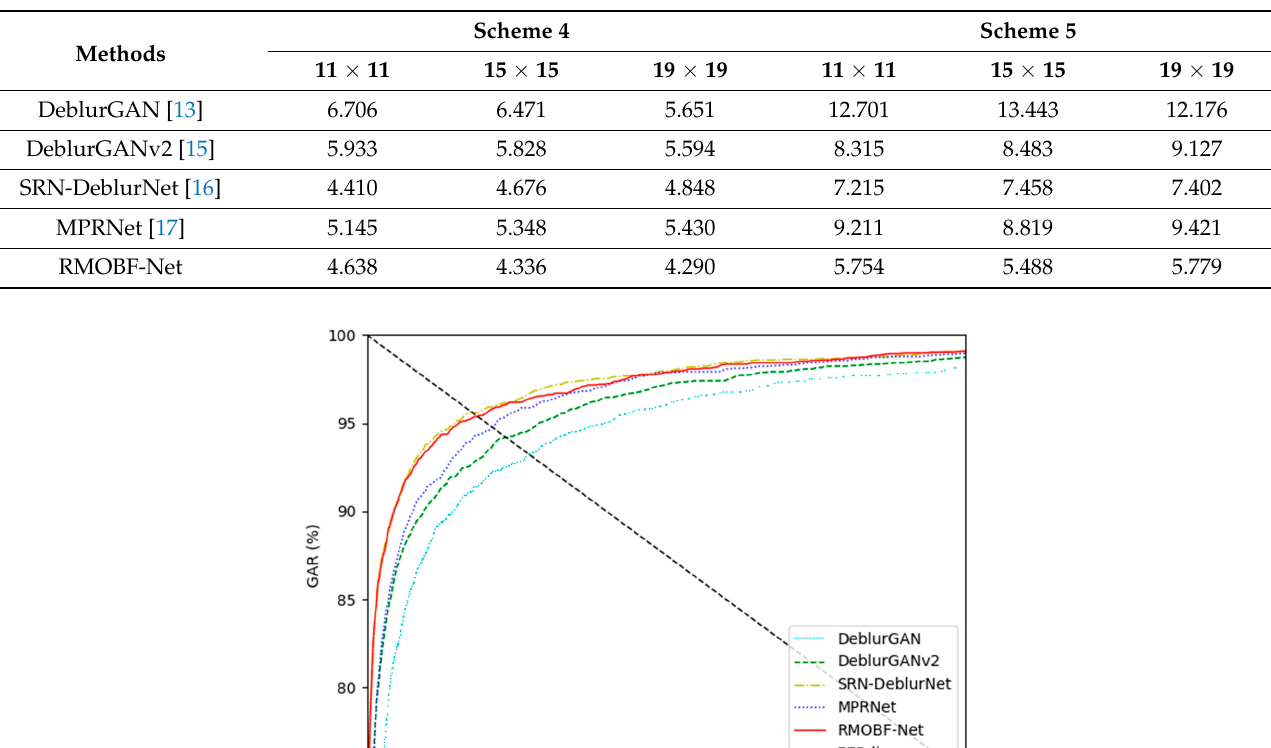
Table 5. Comparisons of finger-vein recognition error (EER) on SDU-DB by schemes 4 and 5 with state-of-the-art restoration models and proposed RMOBF-Net (unit: %).